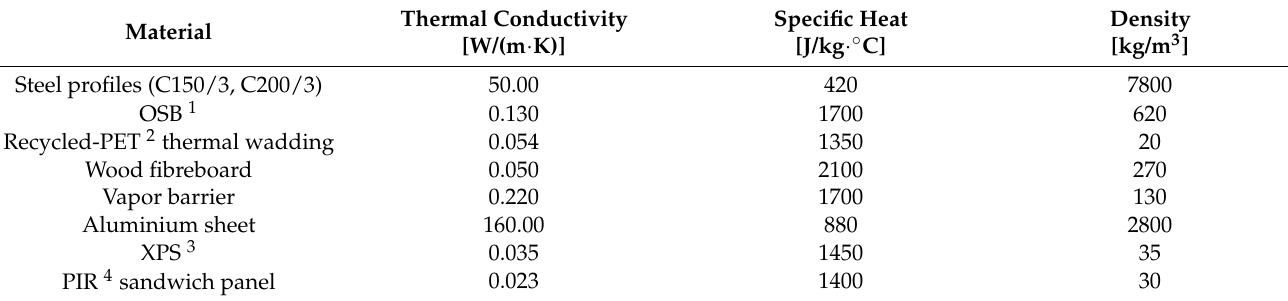
Table 1. Thermal properties of the building envelope materials.